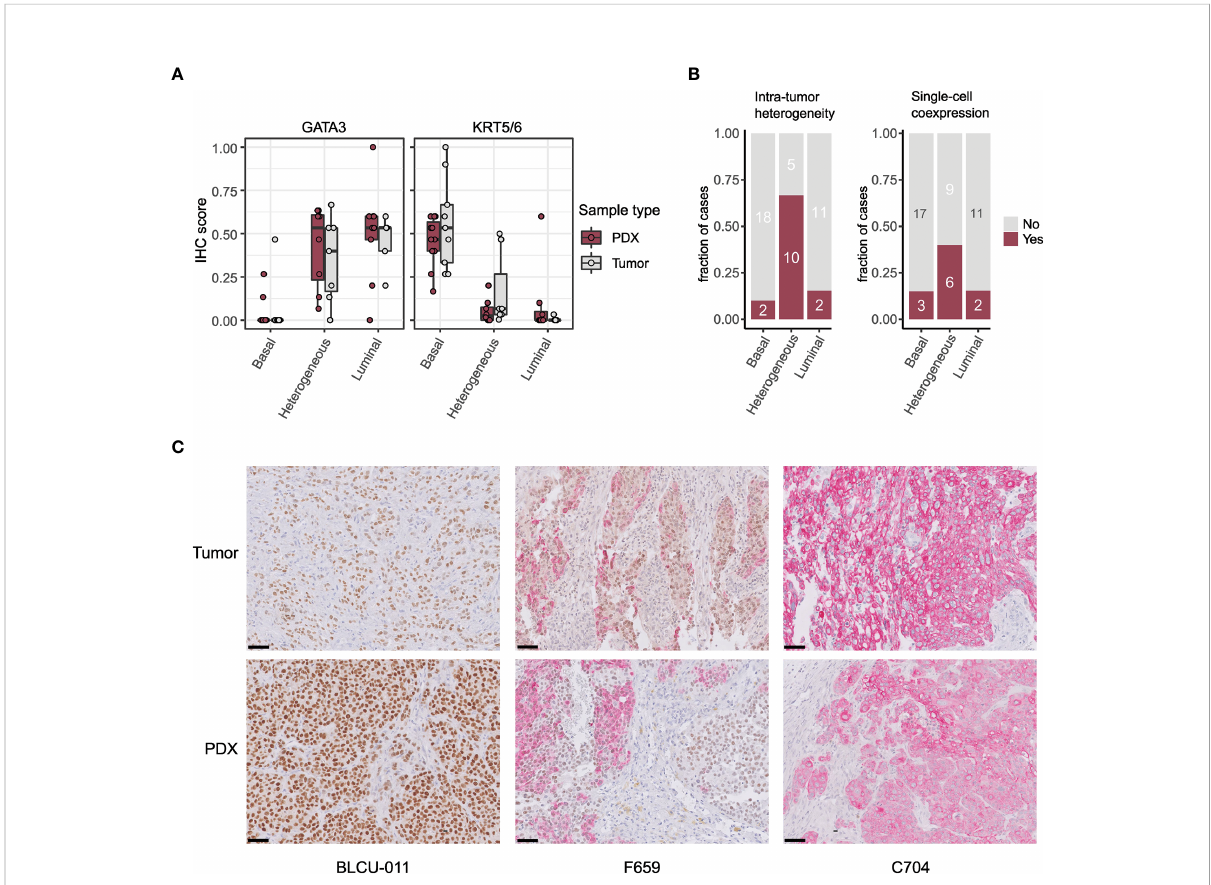
FIGURE 3 Intratumor heterogeneity in tumors and PDXs at the protein level by IHC. (A) GATA3 and KRT5/6 expression levels (normalized quick scores), grouped according to the PDX WISP molecular classi fi cation (luminal, heterogeneous, and Ba/Sq, Figure 2A). (B) Proportion of tumors with intratumoral heterogeneity (left) and GATA3 + KRT5/6 coexpression at the single-cell level (right), grouped according to the PDX WISP molecular classi fi cation (luminal, heterogeneous, and Ba/Sq, Figure 2A). (C) Patterns of dual IHC staining for GATA3 (brown, nuclear) and KRT5/6 (red, cytoplasmic) in the paired tumor/PDX of a luminal (BLCU-011), a heterogeneous (F659), and a Ba/Sq (C704)